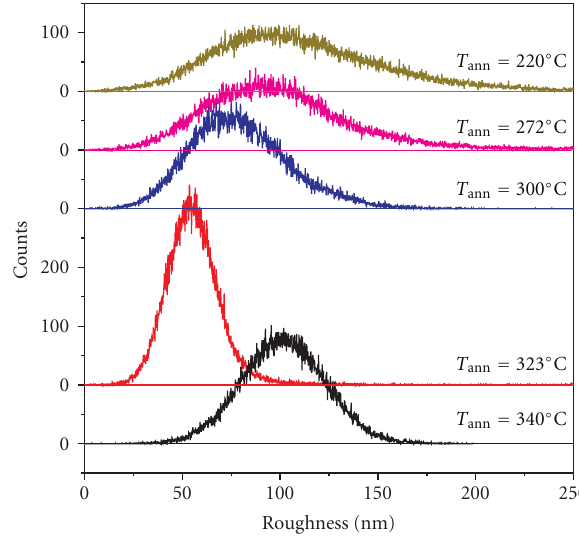
Figure 5: Height distribution histograms obtained by analysing 10 × 10 μ m 2 AFM images measured on In 2 S 3 pristine films deposited at di ff erent